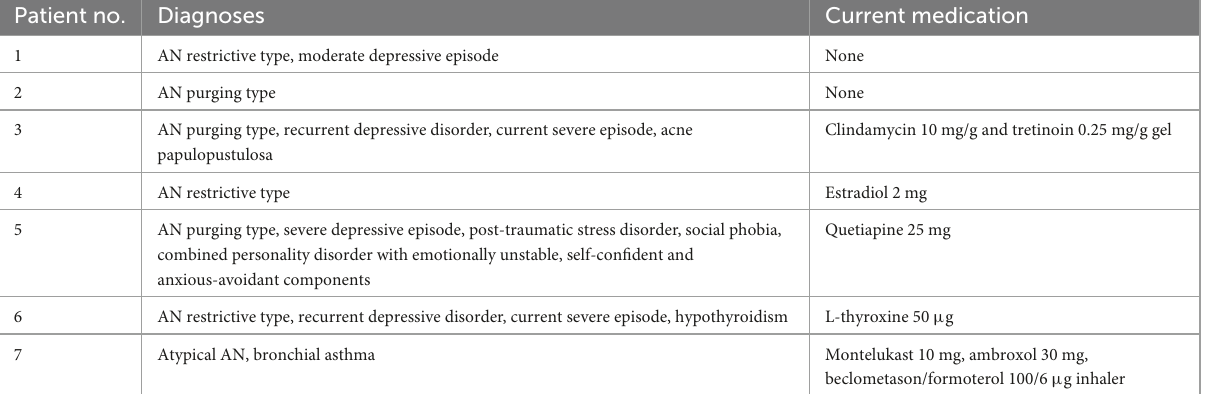
TABLE 1 Diagnoses and current medication of inpatients. Patient